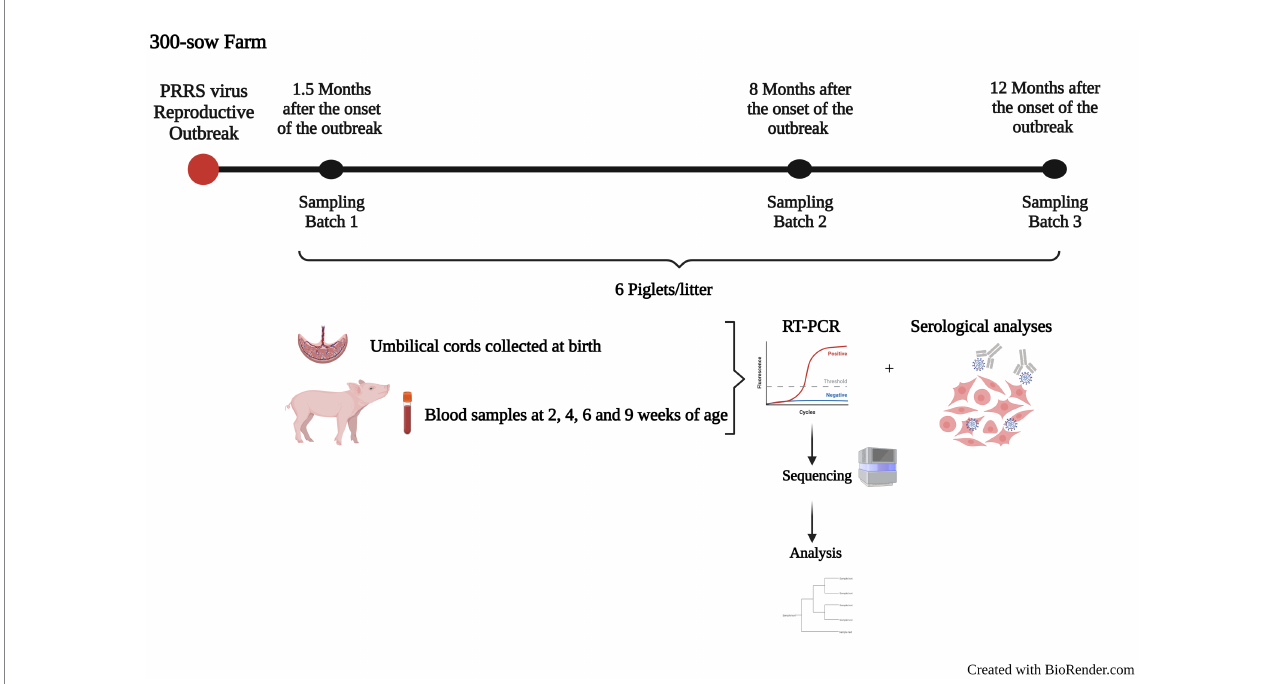
FIGURE 1 Timeline and design of the present study. The figure shows a summary of the follow-up performed in the farm after the onset of a PRRSV-1 reproductive outbreak. Three batches of piglets were followed 1.5 (Batch 1), 8 (Batch 2), and 12 months after the outbreak (Batch 3) from birth to 9 weeks of age. Samples were used to detect PRRSV by RT-qPCR, sequence, and assess the animals’ serological status against